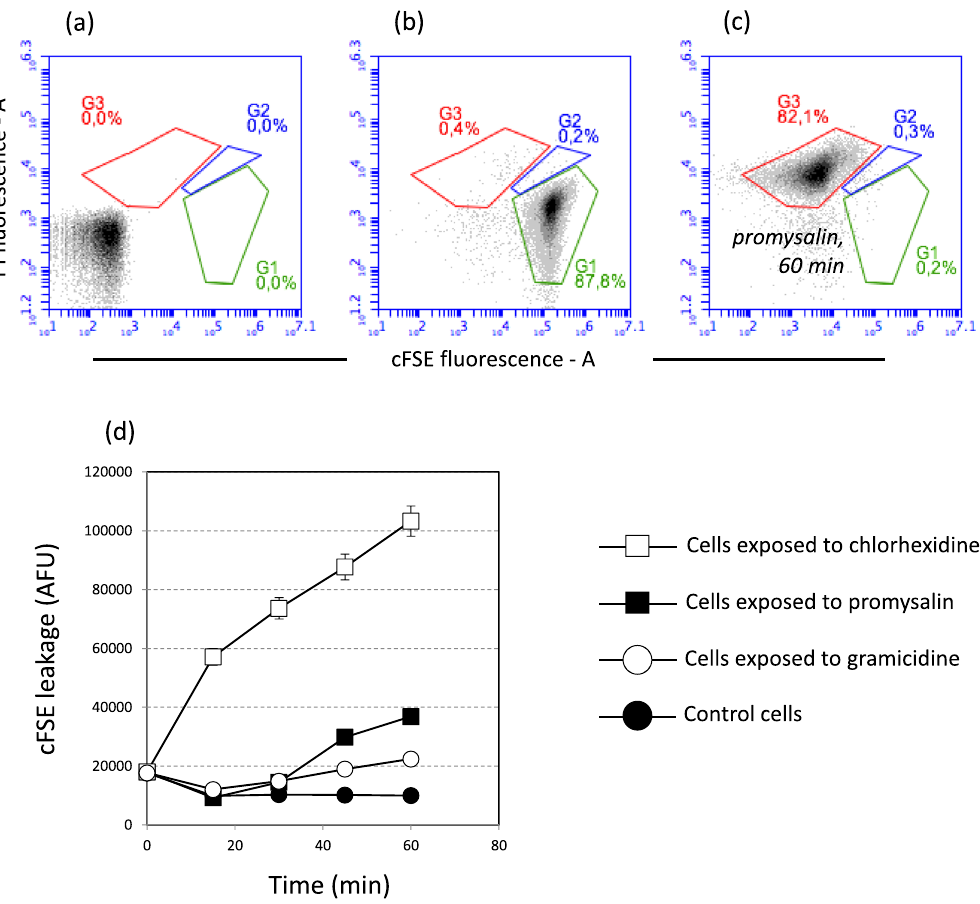
Figure 5. Membrane damage and cFSE fluorescence leakage in S. thermophilus DSM 20617 T exposed to promysalin, chlorhexidine, and gramicidin. Flow cytometry density diagrams show the cFSE vs PI fluorescence of cells exposed to promysalin or chlorhexidine or gramicidin (100, 200 µ g/ml, and 100 µ M respectively). ( a ) Cells before cFDASE labelling. ( b ) Cell labelled with cFSE and PI. ( c ) Cells after 60 min exposure to promysalin. Viable cells are gated in G1, viable cells with slightly damaged cell membrane are gated in G2. Dead cells with damaged membrane are gated in G3. The transition of cell population from gate G1 to gate G3 is related to the entity of cell membrane damage. ( d ) Leakage of cFSE fluorescence outside the cells during the exposure to promysalin, chlorhexidine and the membrane uncoupling